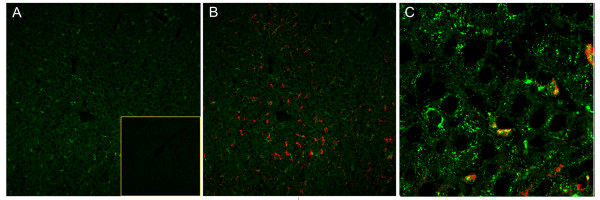
Detection of endogenous LPL in rat liver by immunofluorescence. Tissue sections were double-stained with chicken anti-LPL IgG (detected with Alexa 488-labeled goat anti-chicken antibodies (green)), and the monoclonal anti-Kupffer cell antibody ED2 (detected with Alexa 546-labeled goat anti-mouse antibodies (red)). All panels show sections from livers of rats that did not receive heparin. The magnification in panels A and B was × 20-fold whereas it was × 60 + zooming in panel C. Panel A shows staining only for LPL. Panel B is the same area as in A but with staining also for ED2. Panel C shows both stainings. The inset in panel A shows a control section with non-immune chicken IgG instead of anti-LPL.